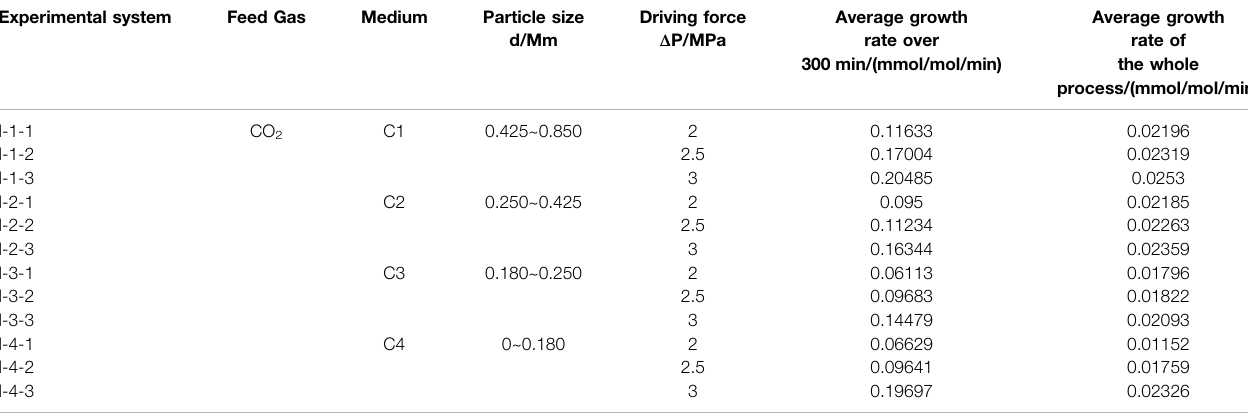
TABLE 2 | Average growth rate of CO 2 hydrates in coal particles under the different driving forces. Experimental system